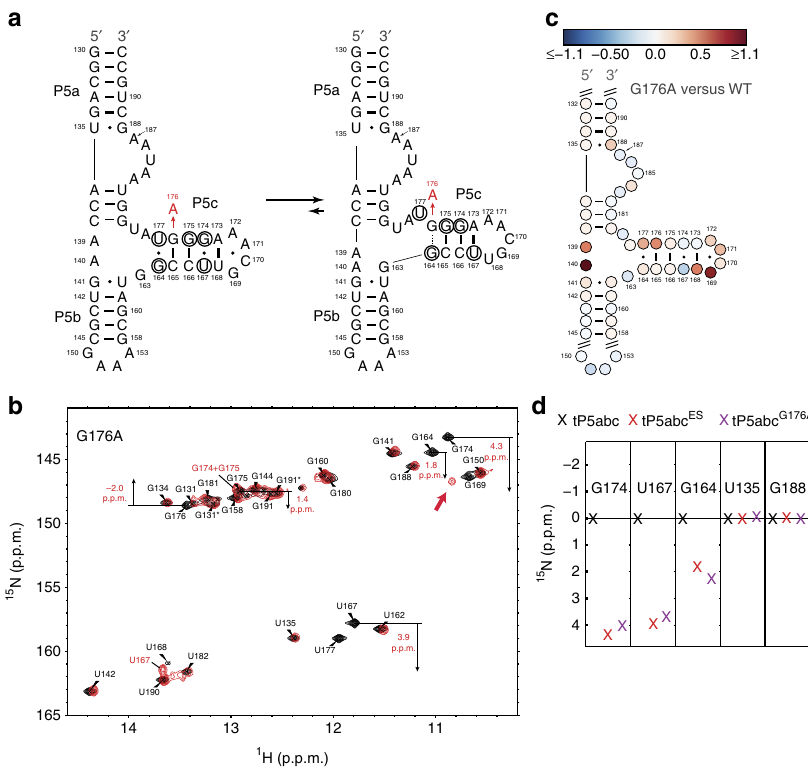
Figure 4 | Analysis of the ES-mutant tP5abc G176A . ( a ) Stabilizing the ES using the tP5abc G176A mutant. Residues disappearing or showing large differences in chemical shifts relative to WT are circled in black. ( b ) 2D 1 H- 15 N HSQC spectrum of 2mM tP5abc G176A in 10mM sodium phosphate and 0.01mM EDTA (pH 6.4) at 10 (cid:2) C (red) overlaid on spectrum of WT tP5abc under the same condition (black). The residues showing pronounced RD in WT tP5abc are highlighted by black arrows starting at 15 N chemical shift of GS and ending at 15 N chemical shift of ES, and are labelled with the associated Do . An unassigned guanine resonance in the sheared G (cid:3) A region is highlighted by thick red arrow. ( c ) Differential SHAPE reactivity measured on tP5abc G176A relative to WT. Red (blue) represents more (less) reactivity, respectively. The data were collected in the absence of Mg 2 þ . ( d ) Comparison of 15 N chemical shifts for several residues in WT, ES and tP5abc G176A